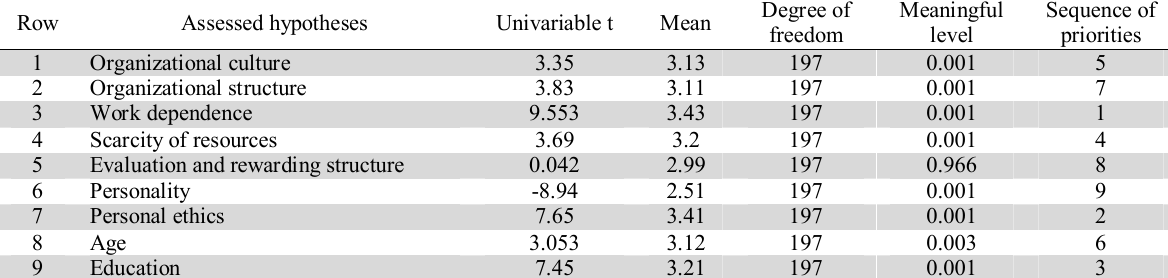
Results from the univariable t-test for hypotheses and their priorities